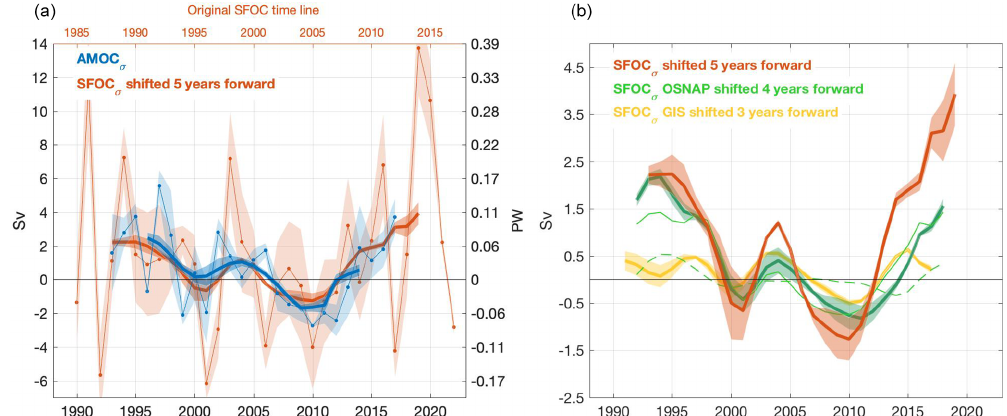
Figure 4. The AMOC σ and SFOC σ time series. (a) Annual anomalies in the maximum AMOC σ (blue) and the maximum SFOC σ (red) at 45 ◦ N (in Sv), with the latter shifted 5 years forward (lag of maximum correlation). The reference (time-mean) period is 1996–2013. Thick lines show 7-year low-pass-filtered time series. The right-hand side axis displays the corresponding heat transport anomalies. The original time line for SFOC σ is given in the top x axis. (b) The 7-year low-pass-filtered time series of anomalies in the maximum SFOC σ at 45 ◦ N (red – shifted 5 years forward), the maximum SFOC σ at the OSNAP line (green – shifted 4 years forward) decomposed into contributions from the eastern (thin) and western (dashed) basins, and the maximum SFOC σ at the GIS sills (yellow – shifted 3 years forward). Shading indicates the ensemble standard errors for each